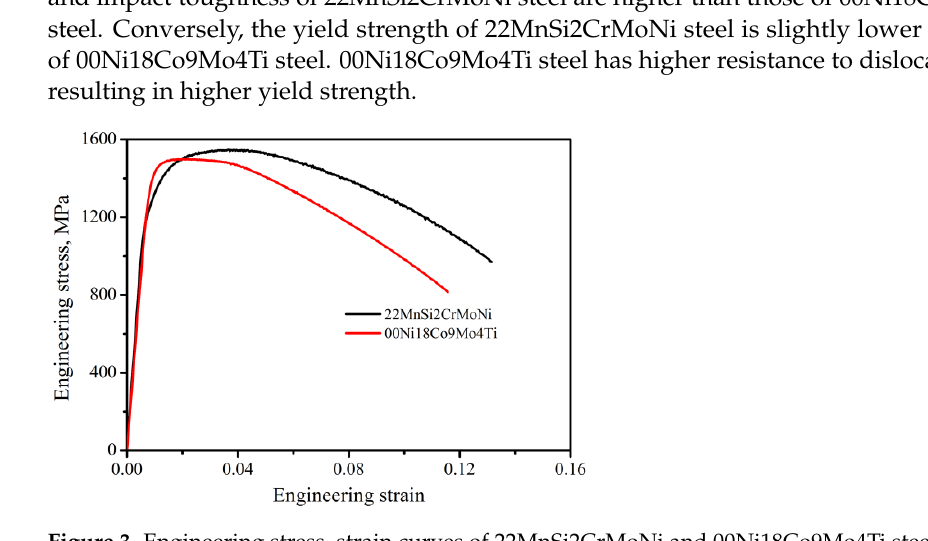
Figure 3. Engineering stress–strain curves of 22MnSi2CrMoNi and 00Ni18Co9Mo4Ti steel. Table 2. Mechanical properties of 22MnSi2CrMoNi and 00Ni18Co9Mo4Ti steel.